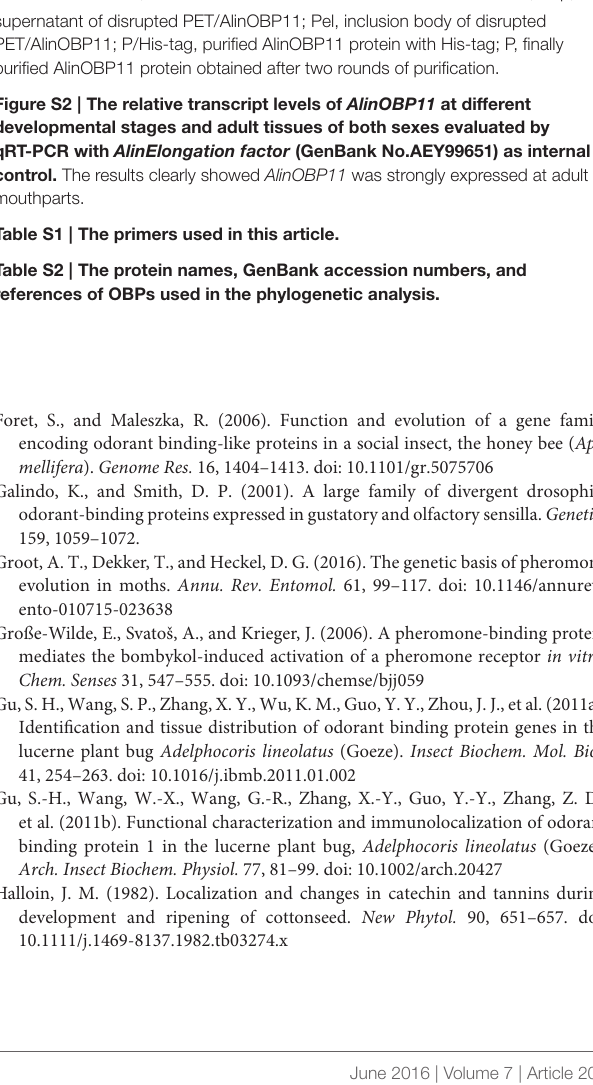
Figure S1 | SDS-PAGE analyses of AlinOBP11 expression and purification. Protein markers are shown in the left side; − , crude bacterial extract before induction with IPTG; + crude bacterial extracts after induction with IPTG; Sup, supernatant of disrupted PET/AlinOBP11; Pel, inclusion body of disrupted PET/AlinOBP11; P/His-tag, purified AlinOBP11 protein with His-tag; P, finally purified AlinOBP11 protein obtained after two rounds of purification. Figure S2 | The relative transcript levels of AlinOBP11 at different developmental stages and adult tissues of both sexes evaluated by